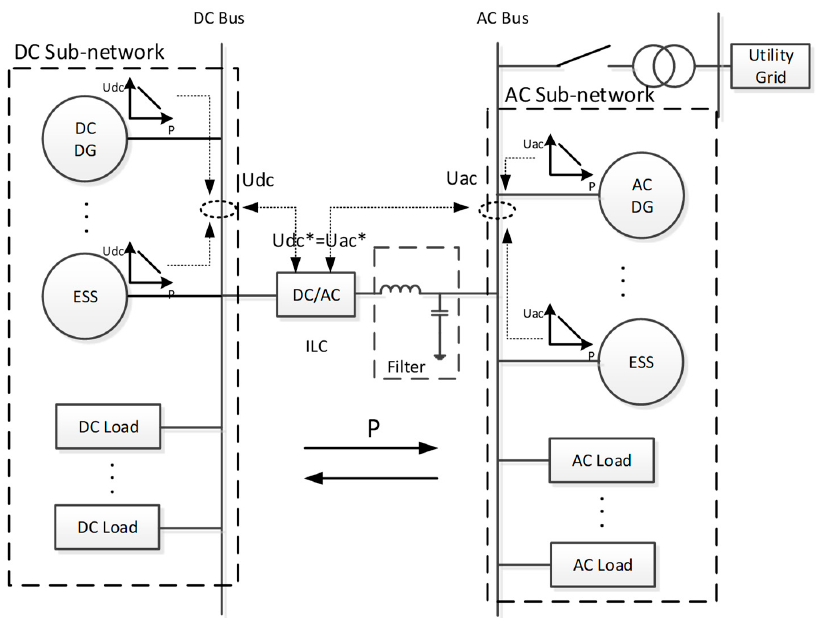
Figure 2. Scheme of entire network droop control.